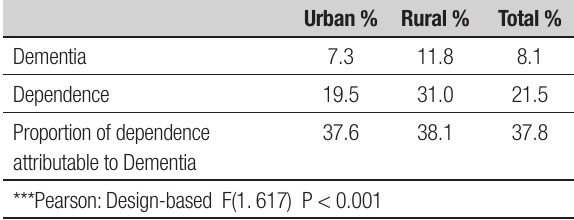
Table 4. Logistic regression model for dementia with years of education, age, gender and rurality as independent